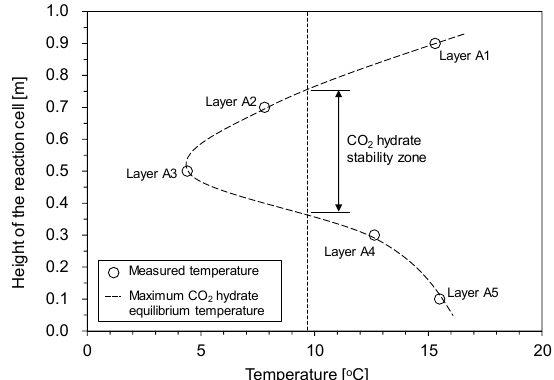
Figure 3. Temperature distribution of the high-pressure cell obtained from the preliminary test result with distilled water. The maximum CO 2 hydrate equilibrium temperature is approximated using the second quadruple point of CO 2 –water mixture (the intersection of the water–CO 2 vapor–CO 2 liquid, and water–CO 2 hydrate–CO 2 vapor equilibrium line) because the water–CO 2 hydrate–liquid CO 2 equilibrium line is essentially vertical in the pressure–temperature diagram